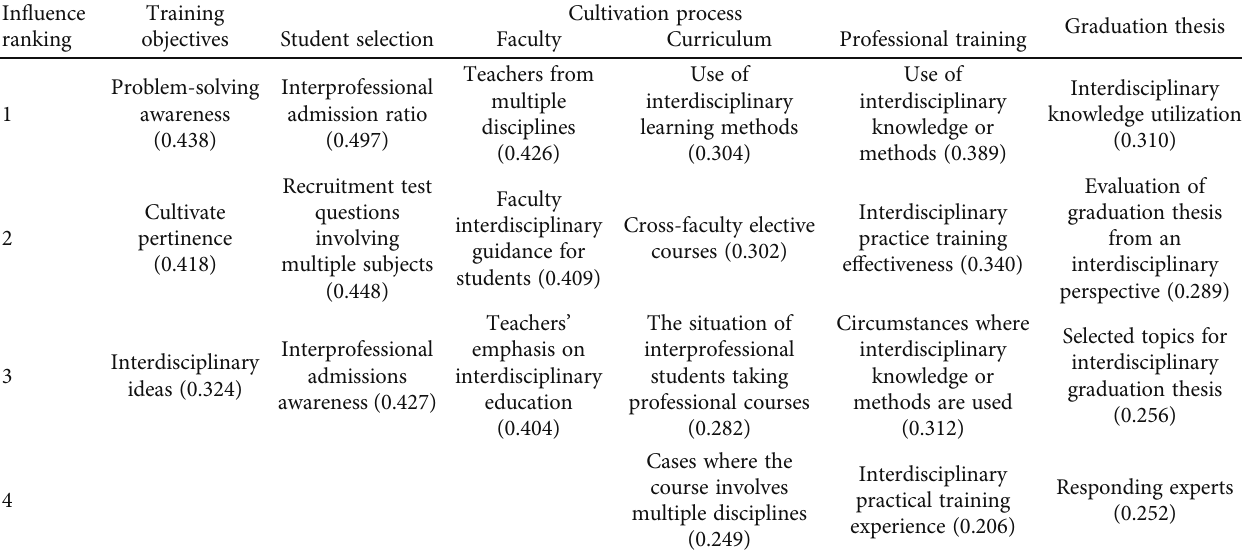
Table 5: In fl uence ranking of evaluation indicators of each training